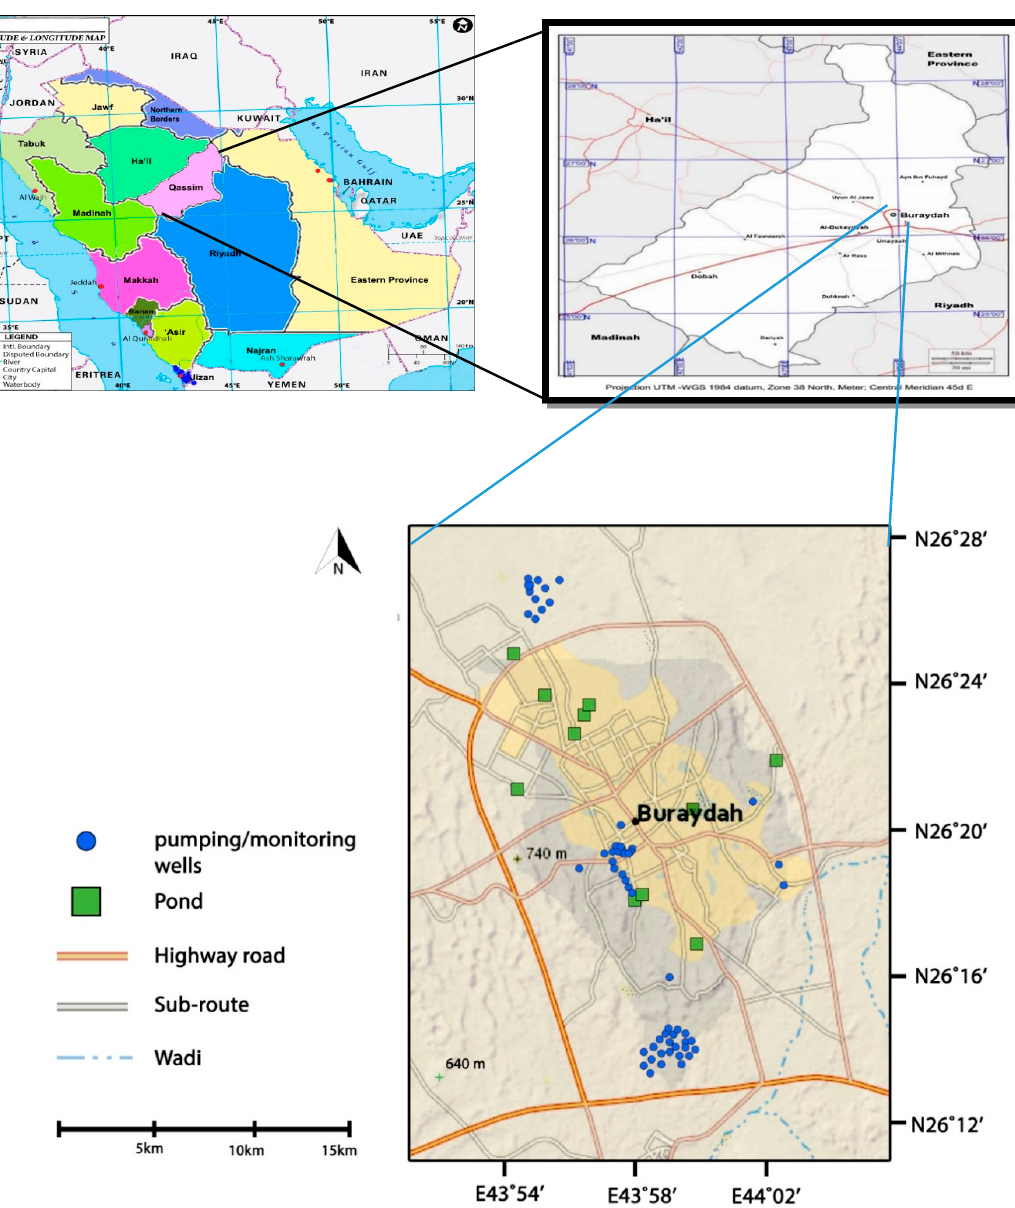
Figure 3. Map of the study area showing the locations of pumping wells (after Alotaibi et al. [44]. The water supply to the region is mainly dependent upon groundwater. The Saq Aquifer, which is one of the well-known aquifers in Saudi Arabia, is the major source of water supply. The cross-section of the Saq Aquifer is shown in Figure 4. The outcrop of the Saq aquifer is very vast. It encompasses nearly 1200 km only in Saudi Arabia, joining the Jordanian border as far south as longitude 45 ◦ (cid:48) latitude 24 30 N. It is a confined aquifer with a variable thickness changing from 700 m in its northern part to 400 m in its southern part. The average thickness of the aquifer in the study area is nearly 500 m